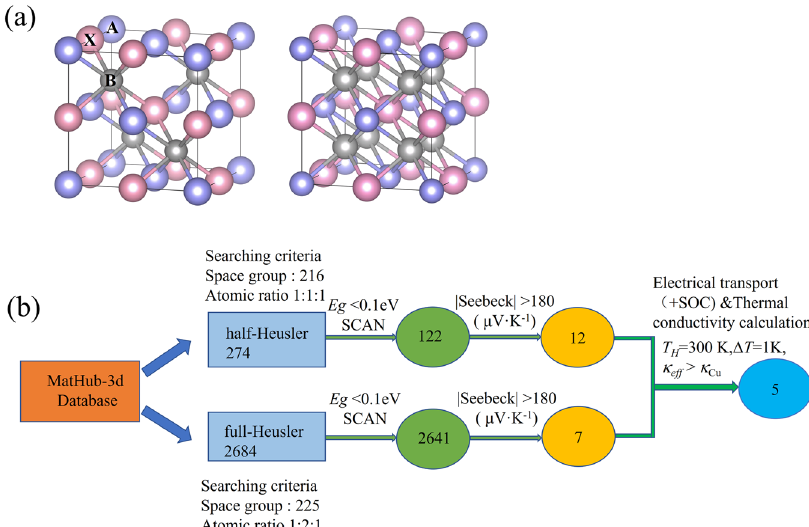
Fig. 2 High-throughput work fl ow of screening Heusler systems in active cooling application. a The crystal structures of half-Heusler and full-Heusler alloys. b The work fl ow of the present